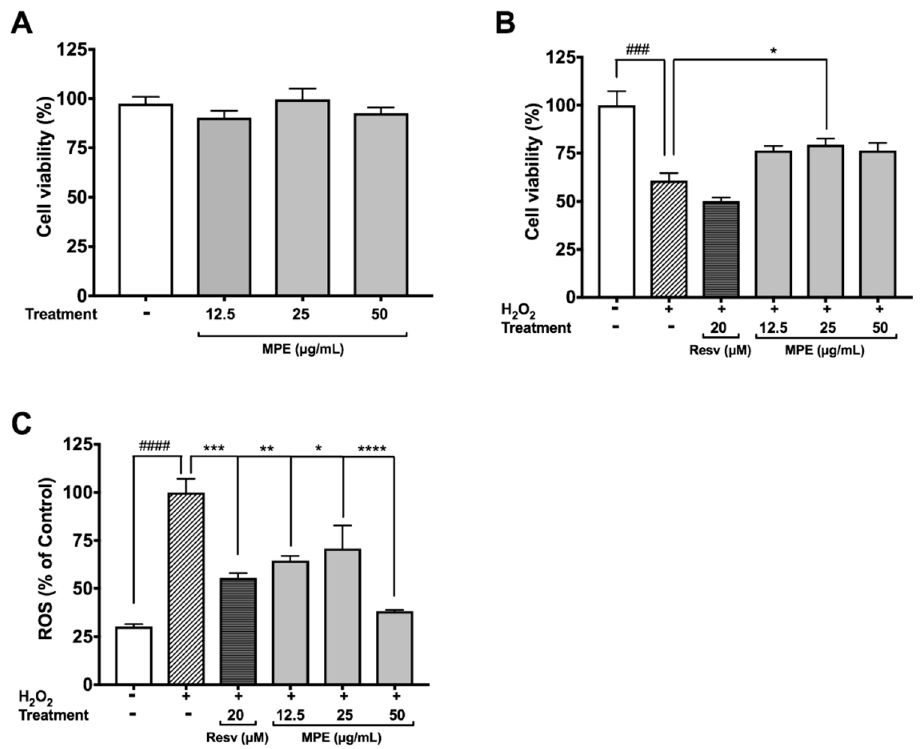
Figure 1. Effects of Mucuna Pruriens Seeds Extract (MPE) (12.5, 25, 50 μ g/mL) on cellular viability and reactive oxygen species (ROS) levels in BV-2 cells. Effects on BV-2 cellular viability by MPE alone ( A ); by MPE after H 2 O 2 -induced BV-2 cell toxicity ( B ); and on ROS levels after BV-2 cell exposure to H 2 O 2 ( C ). All data expressed as mean ± standard error ( n = 3), significance was reported by analysis of variance (ANOVA) followed with Dunnett multiple comparison testing, as compared with control p ≤ 0.001 (###), and p ≤ 0.0001 (####); as compared with toxic agent, p ≤ 0.05 (*), p ≤ 0.01 (**), p ≤ 0.001 (***), and p ≤ 0.0001 (****). Resv—Resveratrol.